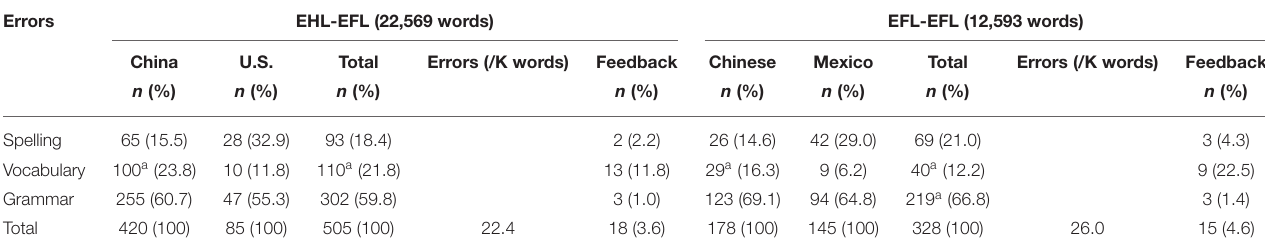
TABLE 3 | Errors and feedback of EHL-EFL and EFL-EFL groups. Errors